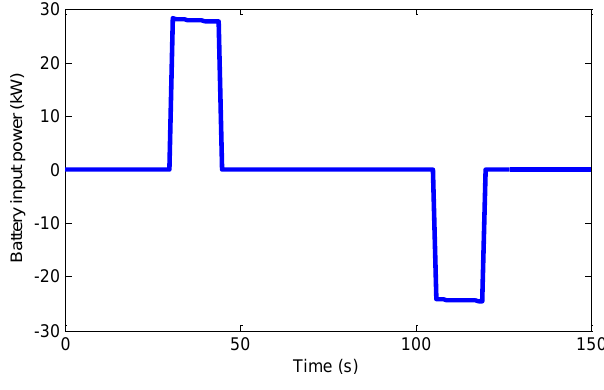
Figure 3. Battery charging/discharging power.